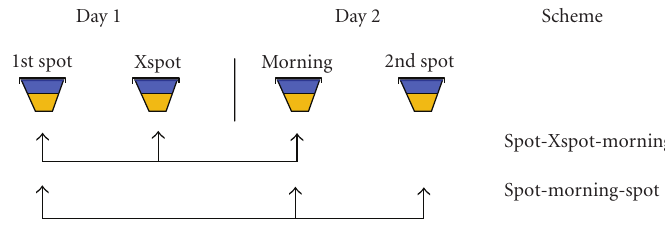
Figure 1: Sputum samples collected and analysed for each scheme.